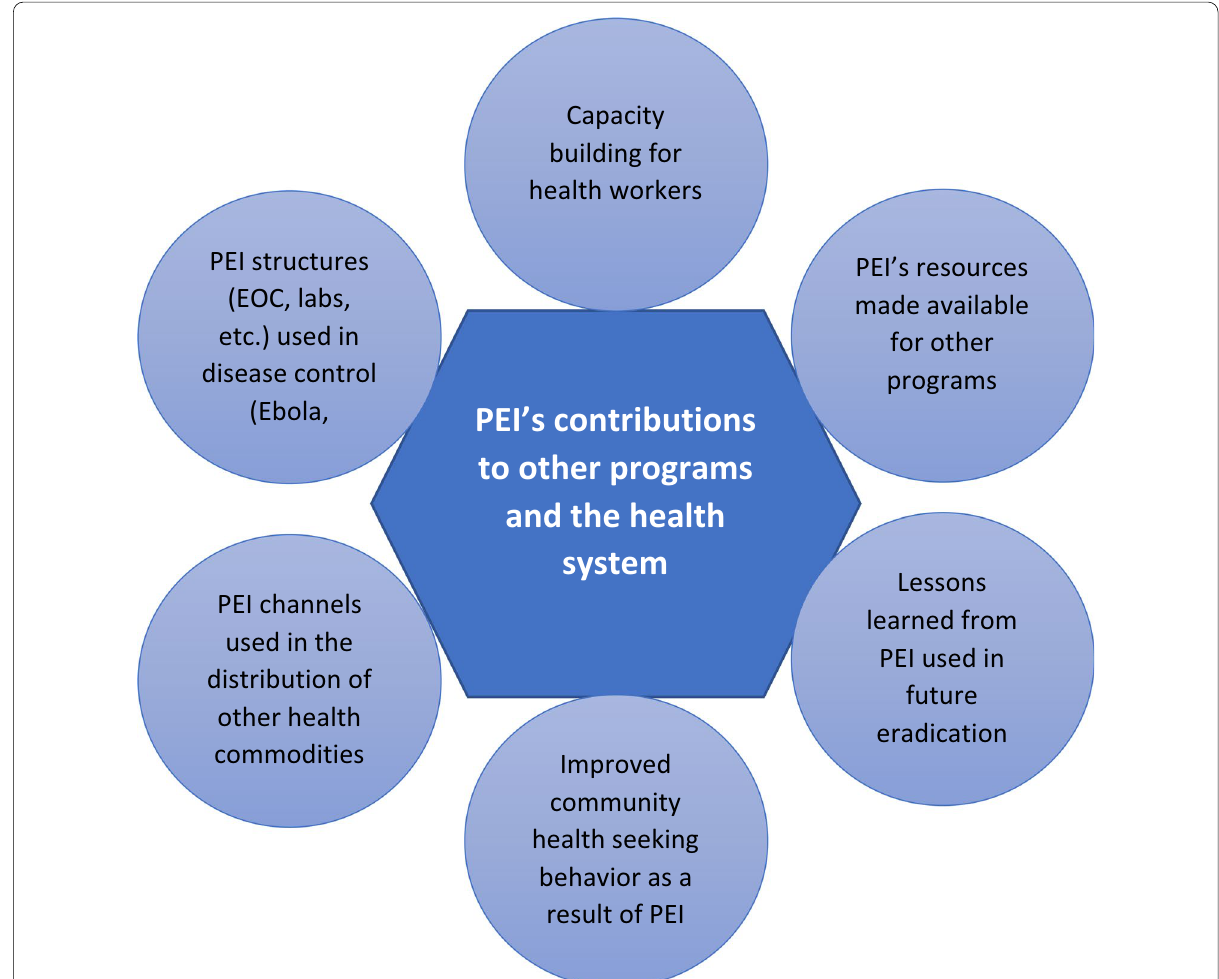
Fig. 1 Contributions of the Polio Eradication Initiative to other health programs and the health